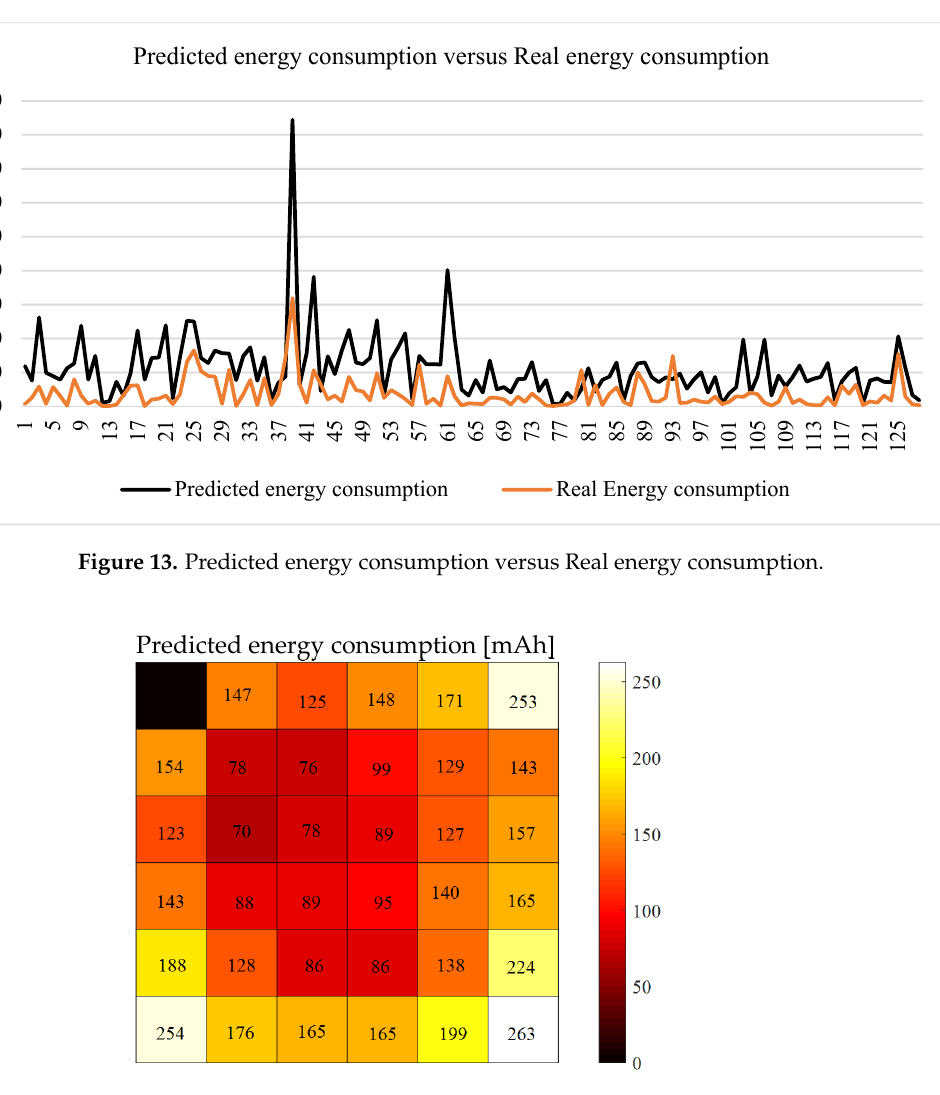
Figure 14. Predicted energy consumption at each intersection for a 6x6 grid [mAh] and RW 470